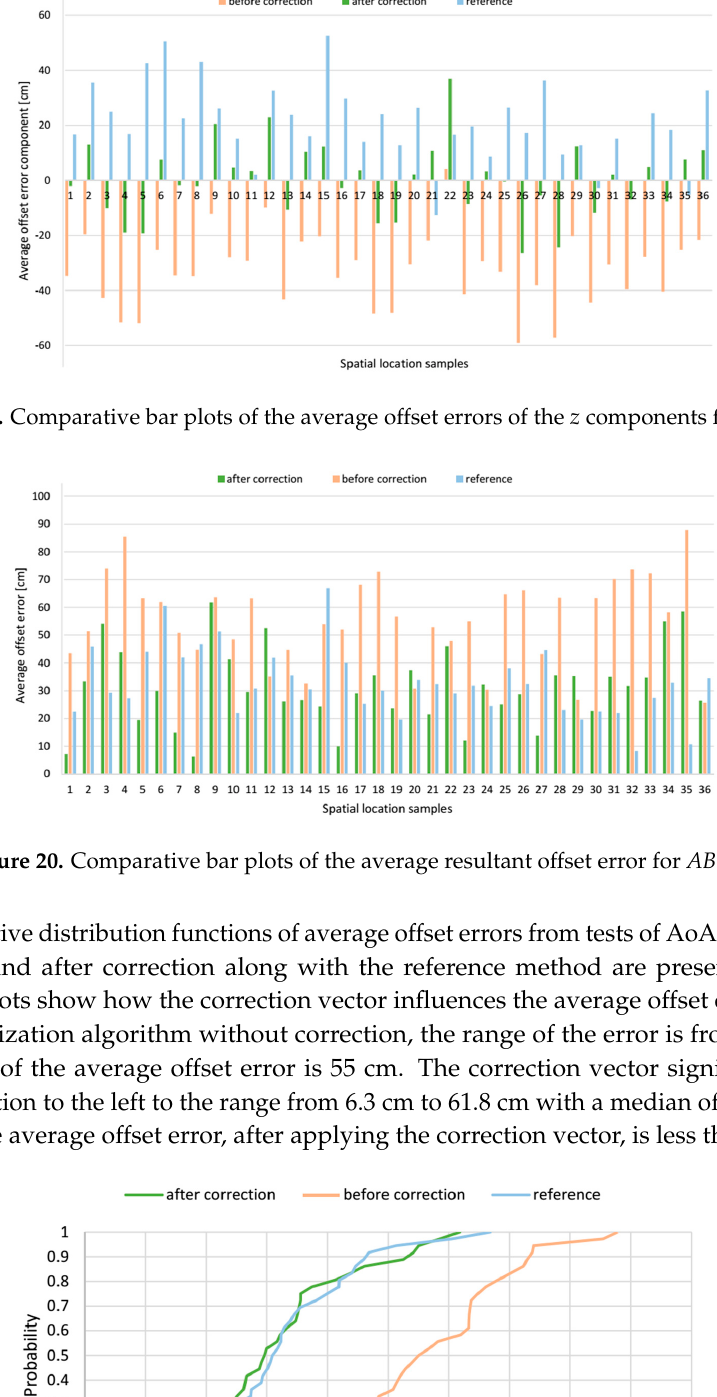
Figure 21. Experimental cumulative distribution functions of the average resultant offset error for LSs AB pair for three algorithms.